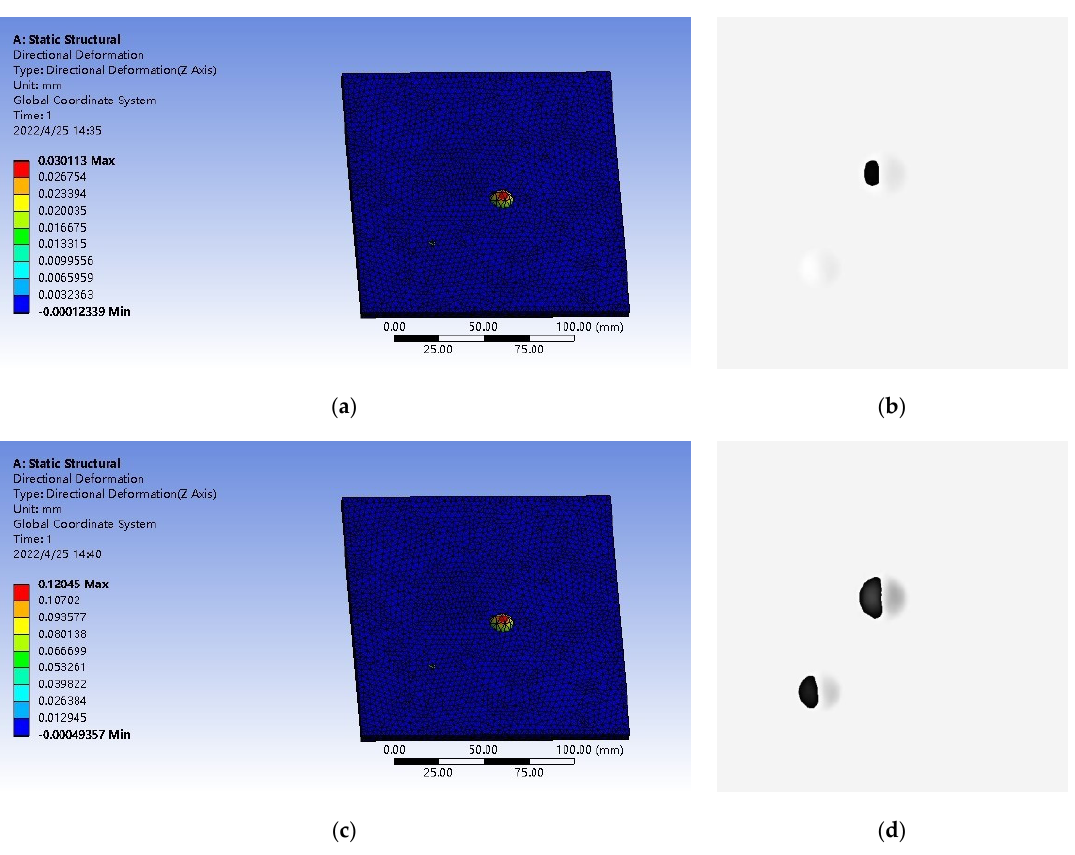
Figure 5. Deformation distributions and shearography images with force loads of 5N and 20N: ( a ) deformation, 5N; ( b ) shearography image, 5N; ( c ) deformation, 20N; ( d ) shearography image, 20N.